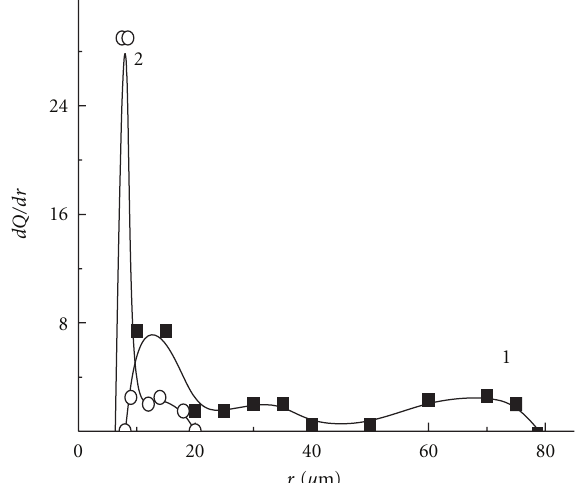
Figure 13: Di ff erential curves of the particle-size distributions for suspensions of the initial carbon (1) and modified with the Na-CAS (2) at 20 ◦ C in the aqueous medium.